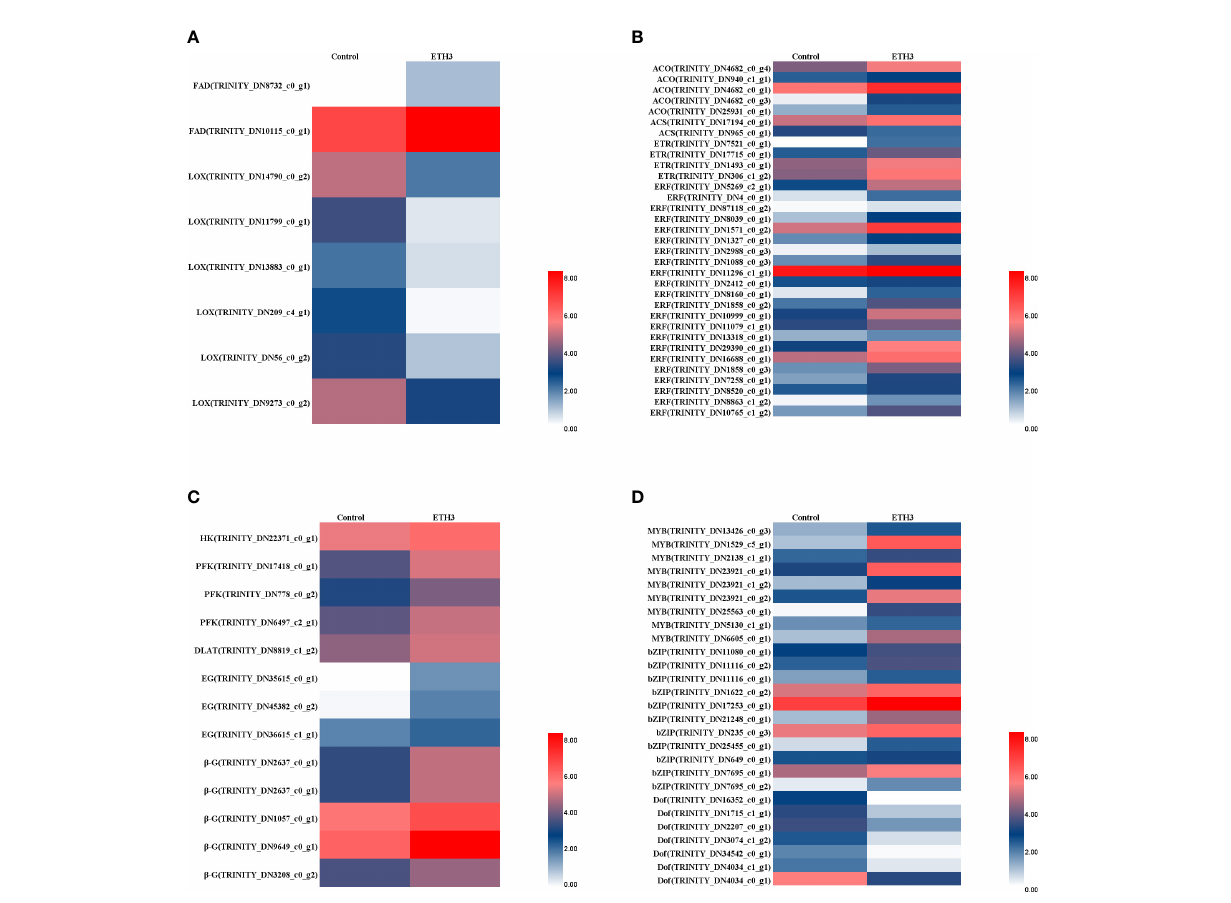
FIGURE 3 Comparison of expression patterns of key genes between the control and ETH3. (A) DEGs related to a -linolenic acid metabolism; (B) DEGs related to ethylene biosynthesis and signal transduction; (C) DEGs related to Glycolysis/Gluconeogenesis; (D) DEGs related to transcription factors. The control and ETH3 indicate the 0 and 1.5 g L -1 ethephon, respectively. Enzyme and chemical names are abbreviated as follows; MYB: v-myb avian myeloblastosis viral oncogene homolog; bZIP, basic leucine zipper; Dof, DNA binding with one fi nger; FAD, fatty acid desaturase; LOX,